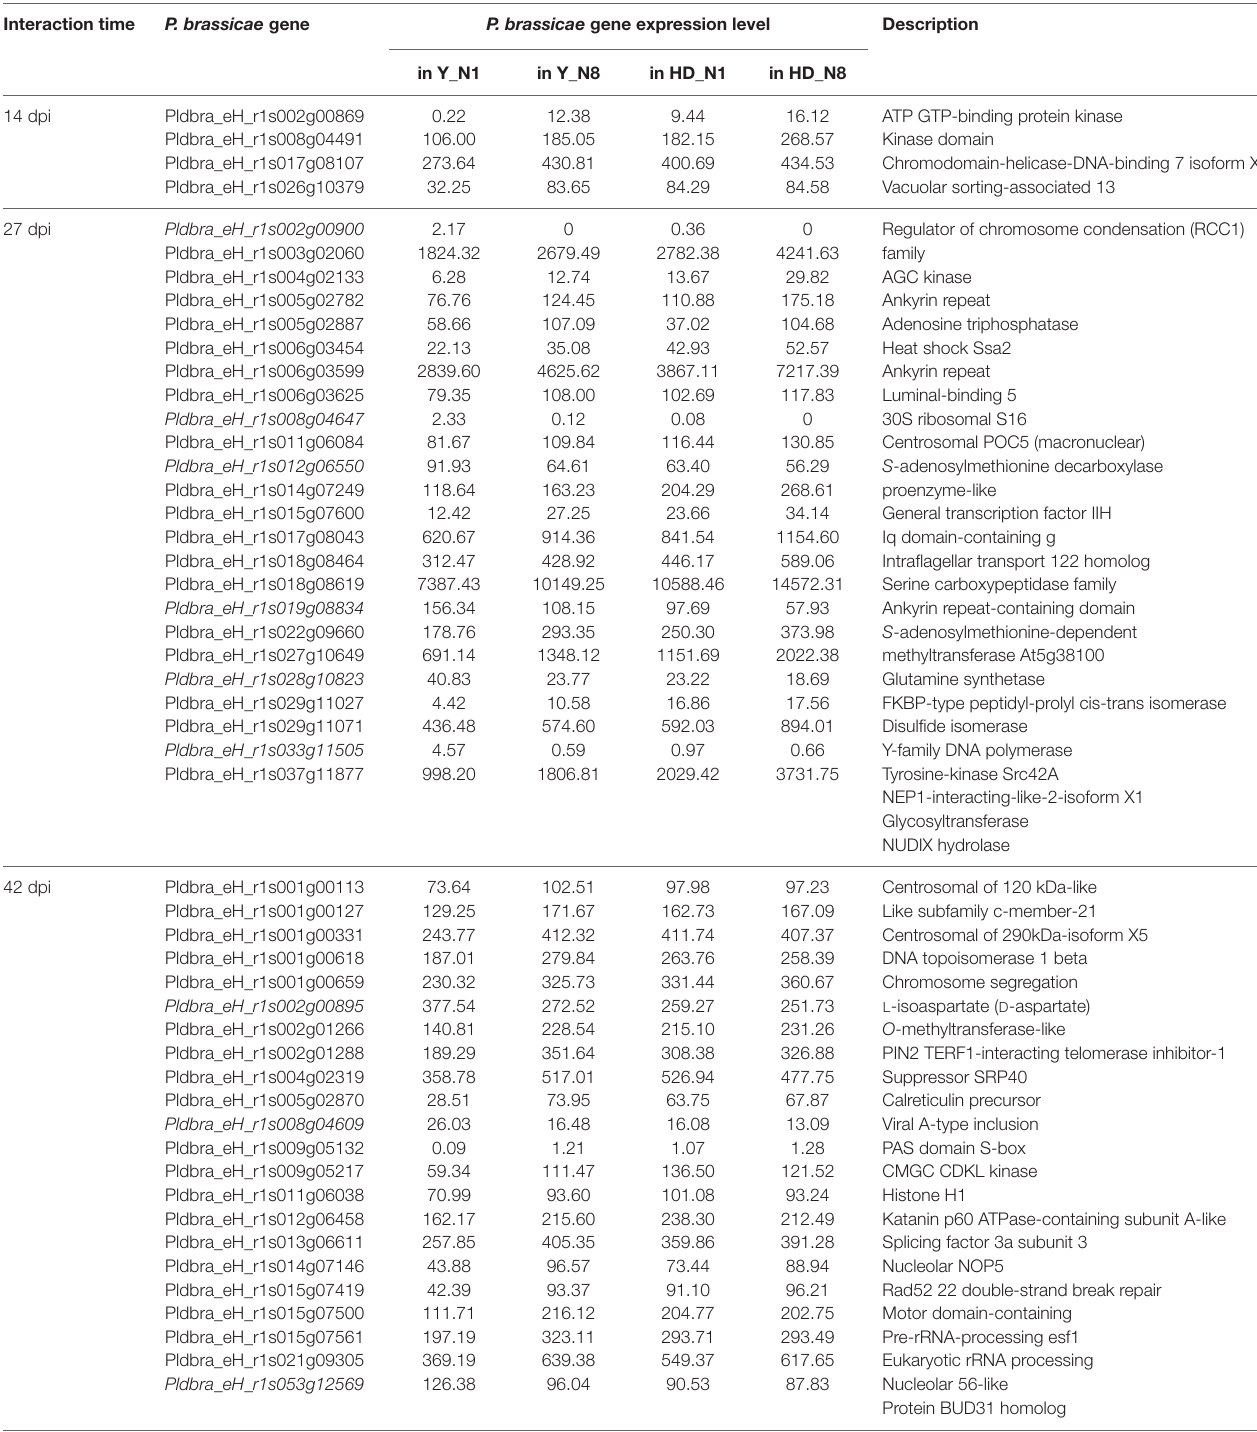
TABLE 3 | Plasmodiophora brassicae genes simultaneously differentially expressed in Y N1 compared to the three other